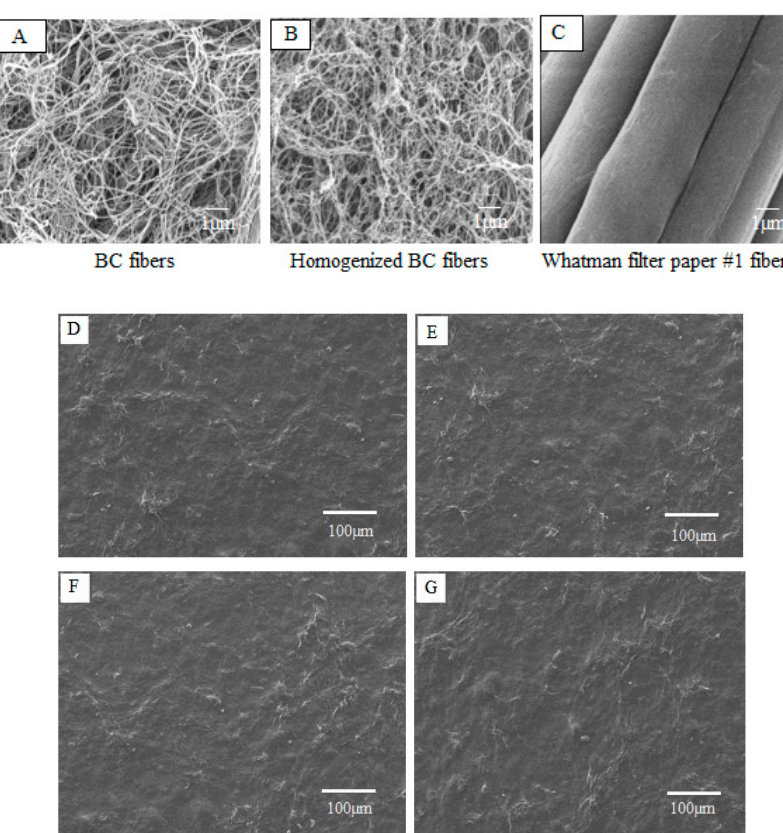
Figure 1. SEM images of: ( A ) BC fibers; ( B ) mechanically-disintegrated BC fibers; and ( C ) Whatman filter paper No. 1 fibers at 10,000 × magnification. Surface morphology of: ( D ) BCAGG-C1; ( E ) BCAGG-C2; ( F ) BCAGG-C3; and ( G ) BCAGG-C4.